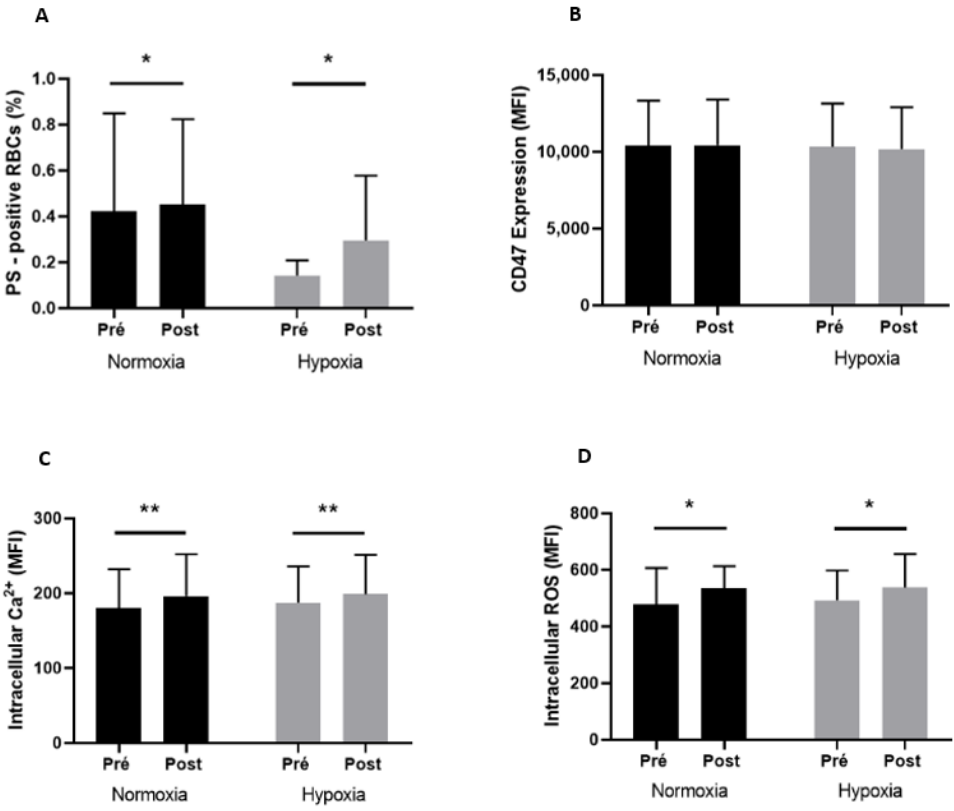
Figure 2. PS-positive RBCs ( A ), CD47 expression ( B ), intracellular Ca 2+ content ( C ), and intracellular ROS content ( D ) before (Pre) and after (Post) exercise, in normoxia and in hypoxia. Difference be- tween pre- and postexercise * p < 0.05, ** p < 0.01.